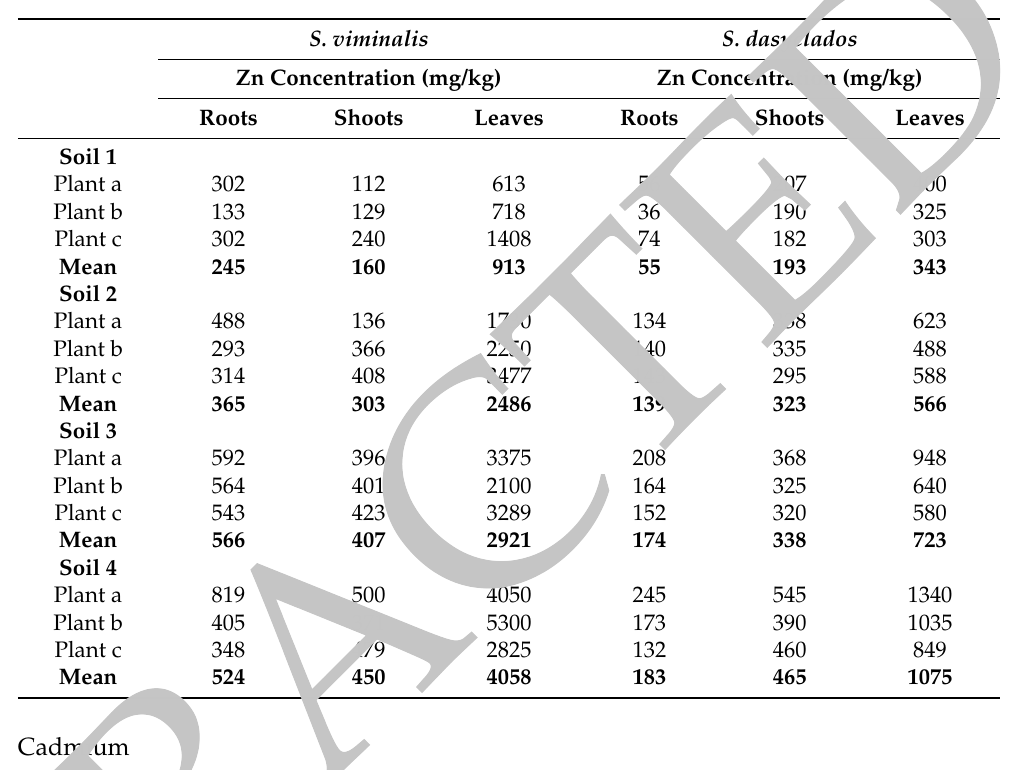
Table 7. Zinc concentrations from analysis of plant samples, corrected for dilution steps.